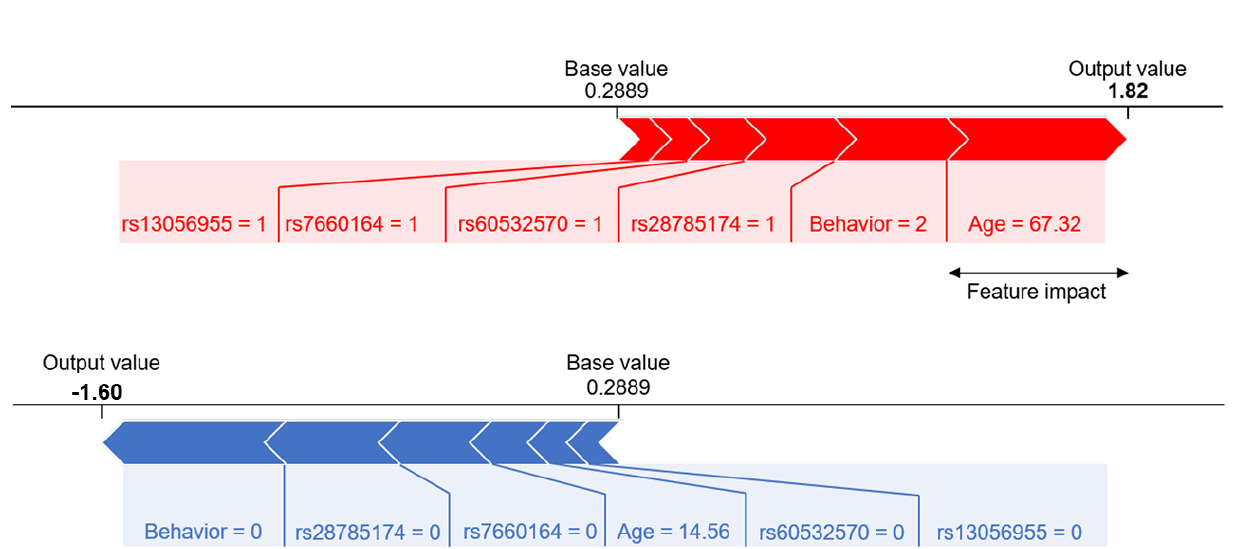
Figure 5. Representative SHAP force plots showing patient profiles of feature importance. Two extreme patients having the highest (upper panel) and lowest (lower panel) model probabilities were selected from the training set. The features are ordered by absolute SHAP value, which is represented by the arrow width. The corresponding feature profile is provided below the bar plot, where “output” and “base” values represent the patient SHAP values and the mean thereof, respectively.